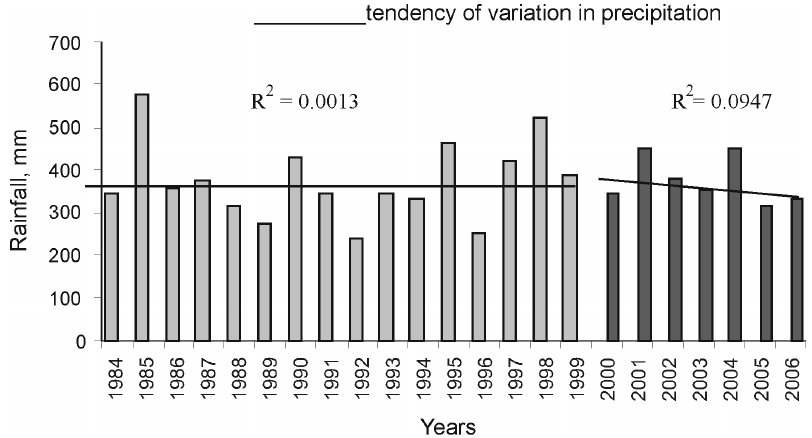
Fig. 4. Variation in the amount of precipitation during the period of active growth (May–October) during 1984–2006 (1984–1999 is the period before damming, and 2000–2006 is the period after damming)